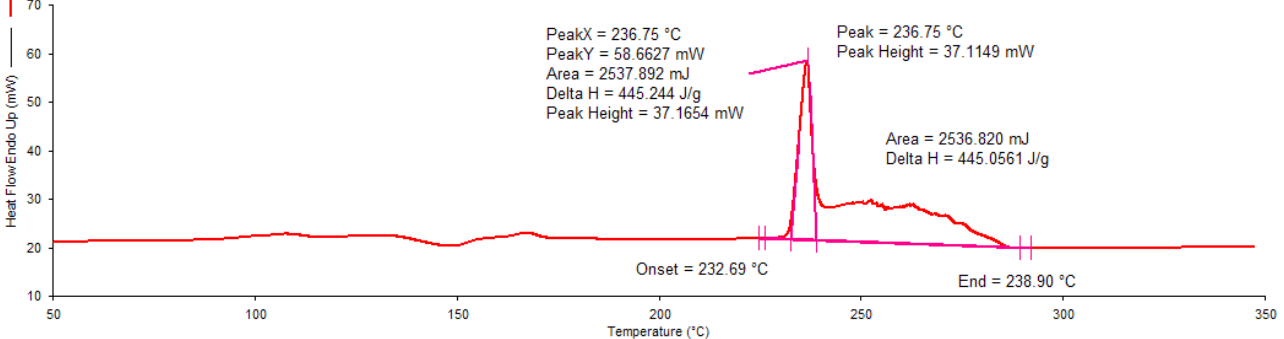
FIGURE 3 - DSC result of mefenamic